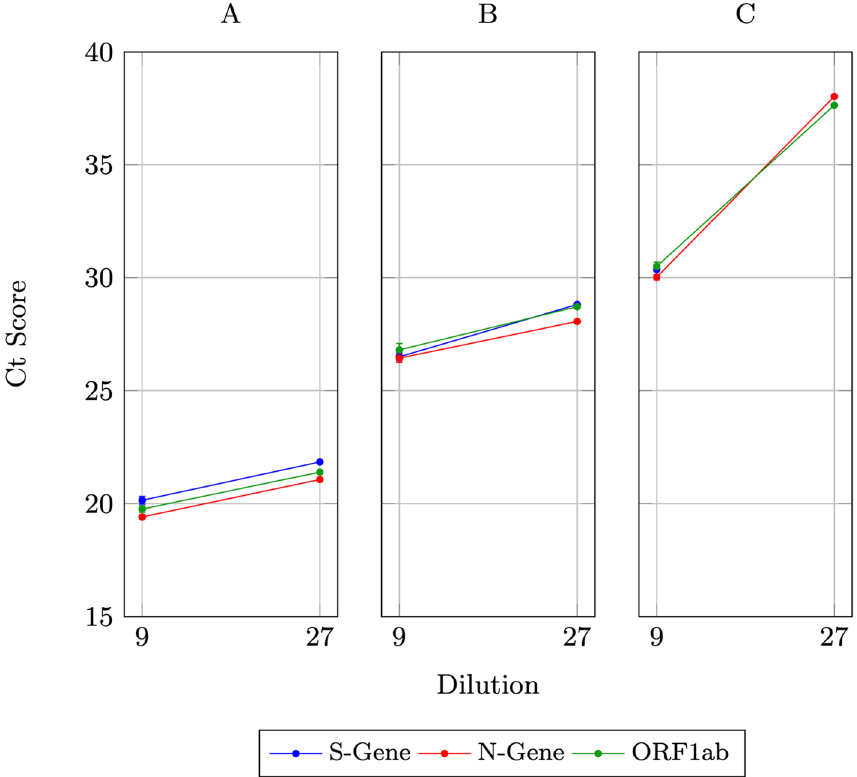
Figure 2. Detection of a single positive sample after ninefold and 27-fold dilution, in 3-d hypercube pooling. Error bars are shown for the 3 positive pools, where the positive sample is diluted